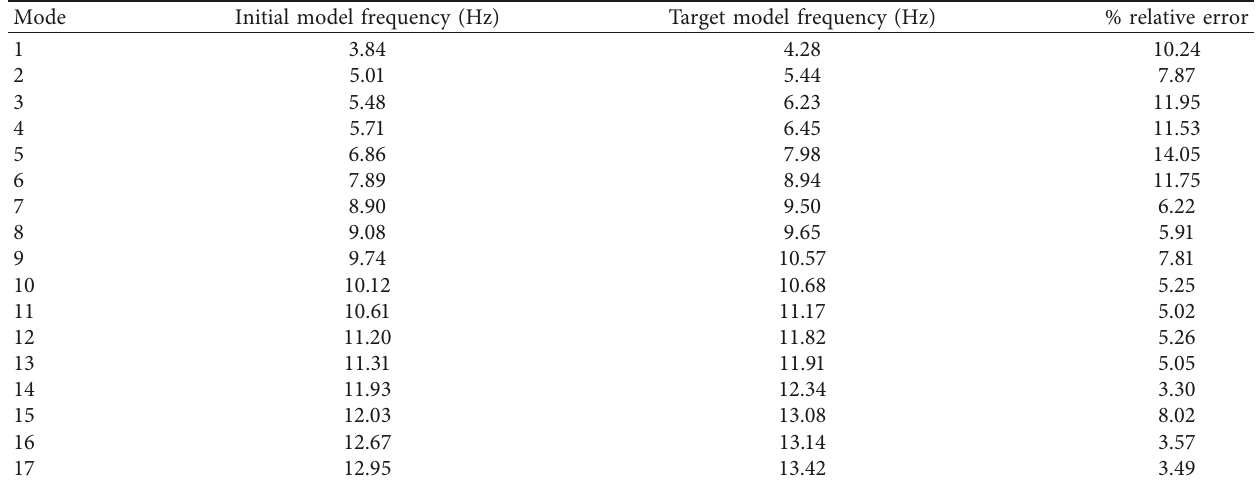
Table 9: Natural frequencies for configuration 1 vs. configuration